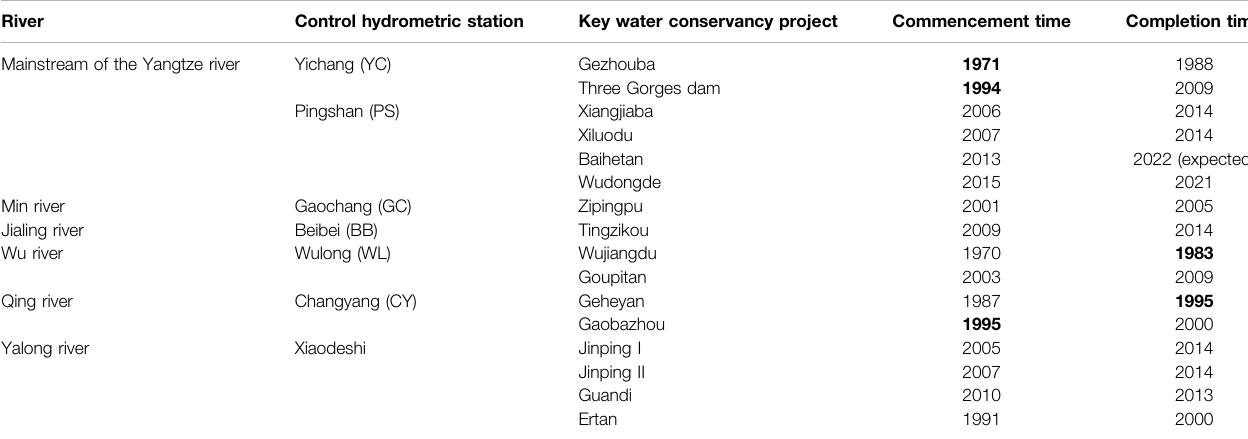
TABLE 7 | The commencement and completion time of key water conservancy projects in the upper Yangtze River. River Key water conservancy project